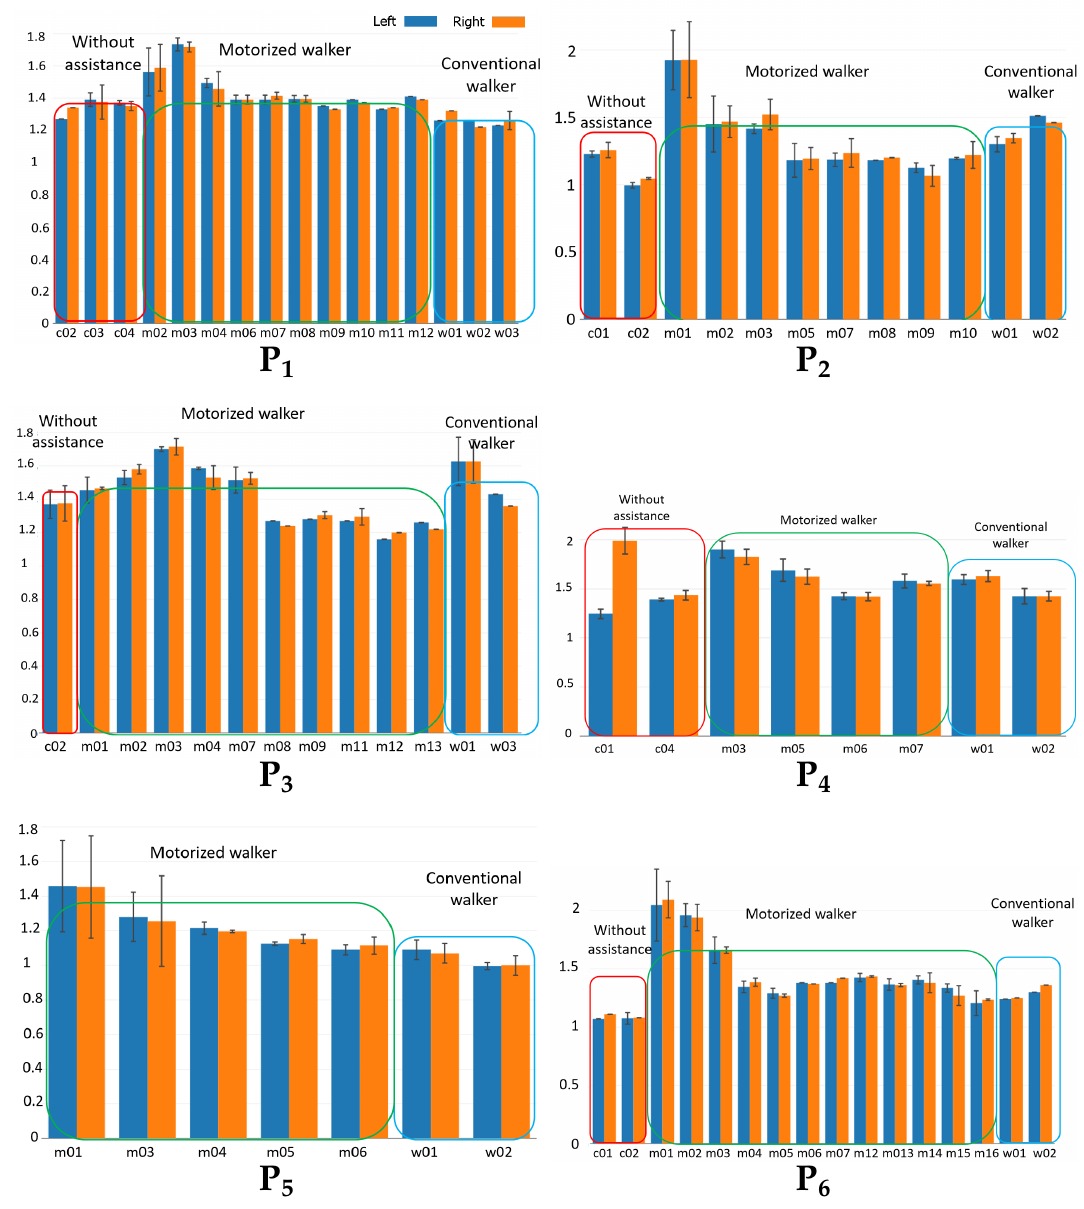
Figure 6. Gait cycle time (GCT) for each of the 6 subjects ( P 1 – P 6 ) without assistance, with motorized walker, and with conventional